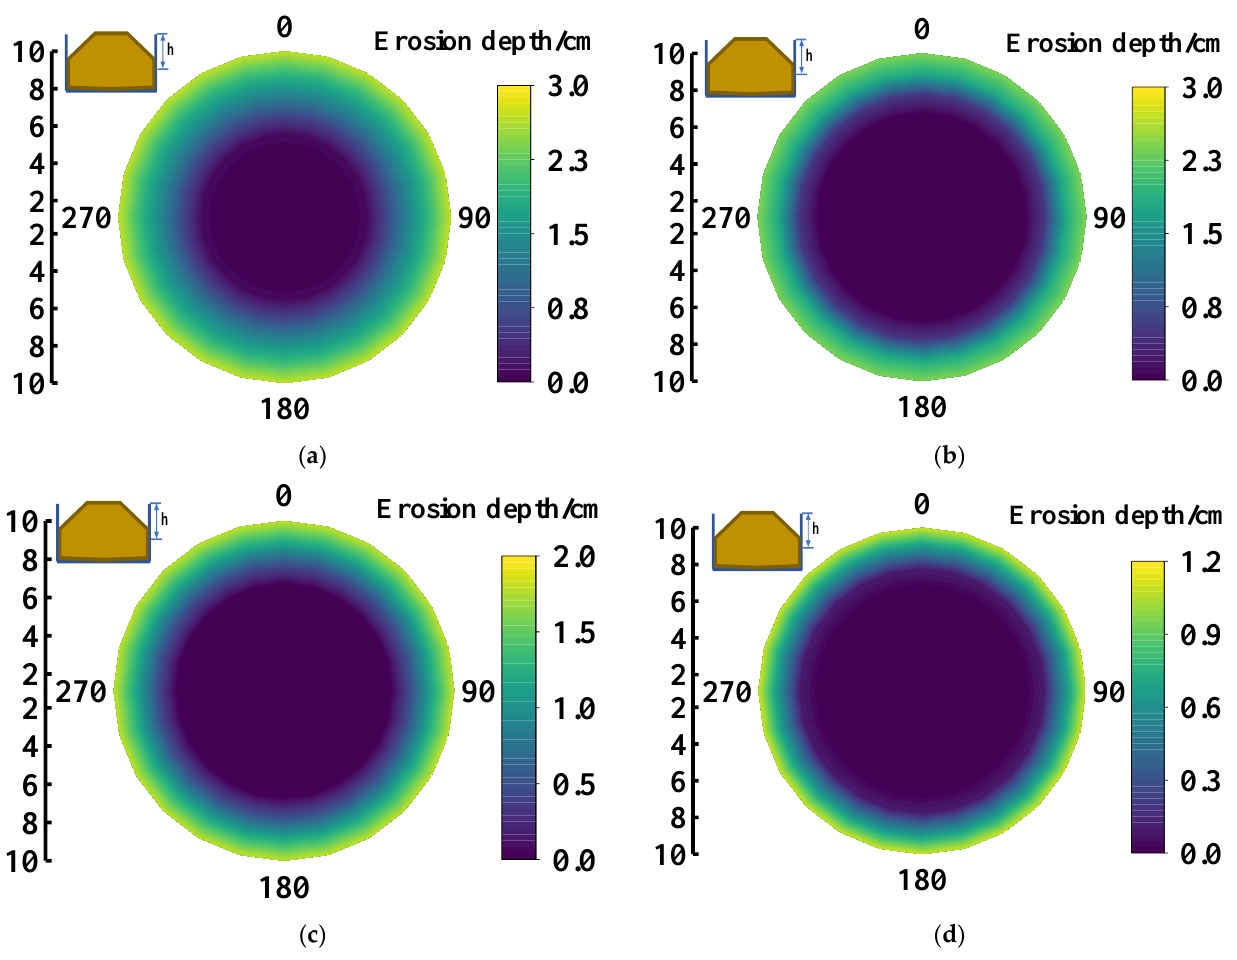
Figure 14. Erosion topography map for each test condition (final setting). ( a ) 50 kPa ( w = 124 rad/s) ( b ) 100 kPa ( w = 123 rad/s) ( c ) 150 kPa ( w = 156 rad/s) ( d ) 200 kPa ( w = 201 rad/s). By observing the surface changes of the solidified soil samples during erosion, the process of solidified soil erosion development can be roughly divided into the following stages: initial formation of the cracks (Figure 15a), gradual development and extension of the cracks (Figure 15b) and, after the final formation of the erosion line, the rapid erosion of the local solidified soil mass at the corresponding location within a relatively short period of time (Figure 15c). This phenomenon is obviously different from the “uniform” erosion of sand. When the partially solidified soil is separated from the rest of the soil sample, it will be rapidly broken into fine particles that become suspended in the water to form turbidity, resulting in the gradual increase in turbidity of the water in the tank. As the erosion depth becomes greater, the hydraulic action on the deep soil decreases, and the erosion eventually reaches equilibrium, as shown in Figure 15d. For solidified soil in the initial setting, the water flow can push the solidified soil at the soil surface from one side to the other (Figure 15a), making it easier to create cracks and thus make the soil more susceptible to erosion. In contrast, the final consolidated soil cannot be pushed, so erosion is difficult.